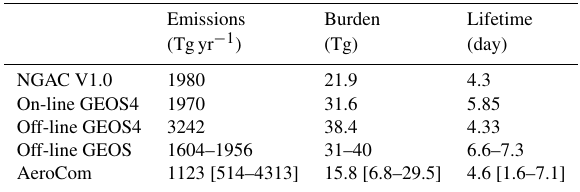
Table 1. Global annual emissions, annual burden and lifetime for dust aerosols ∗